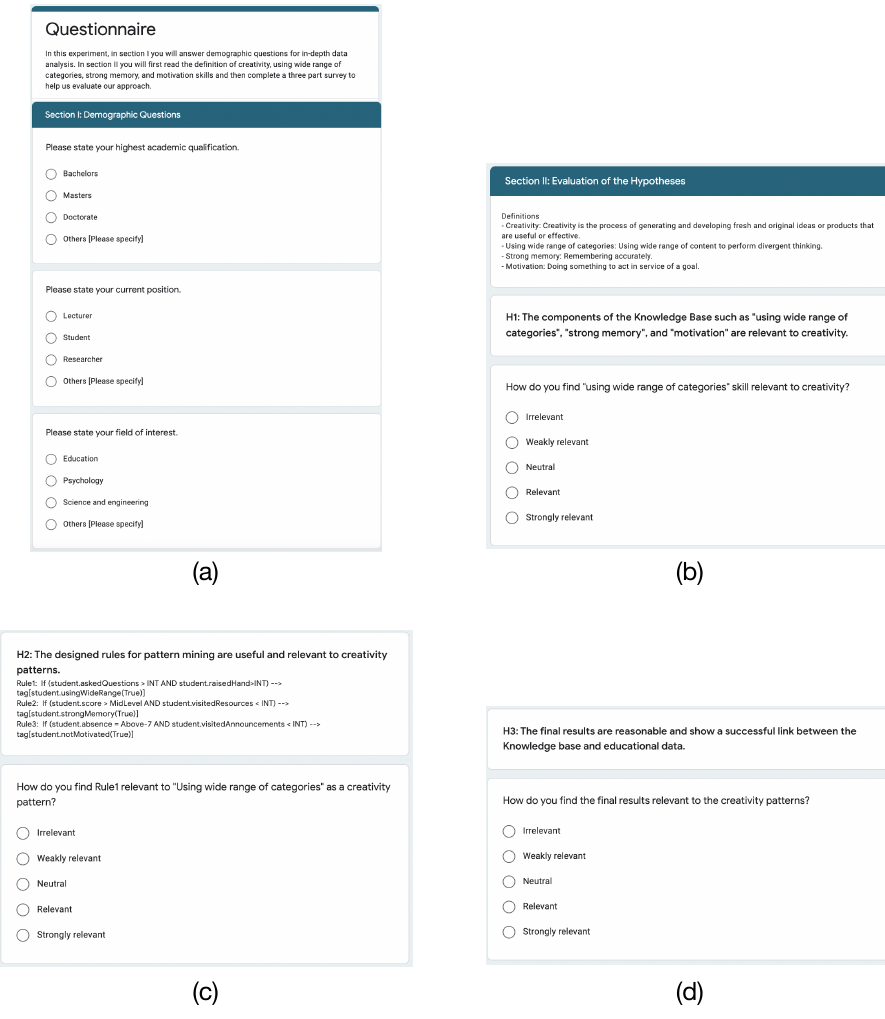
Figure 8. Examples of the questionnaire. ( a ) Demographic questions. ( b ) Evaluation of H1 for the “using a wide range of categories” creativity pattern. ( c ) Evaluation of H2 for the “using wide range of categories” creativity pattern. ( d ) Evaluation of H3.